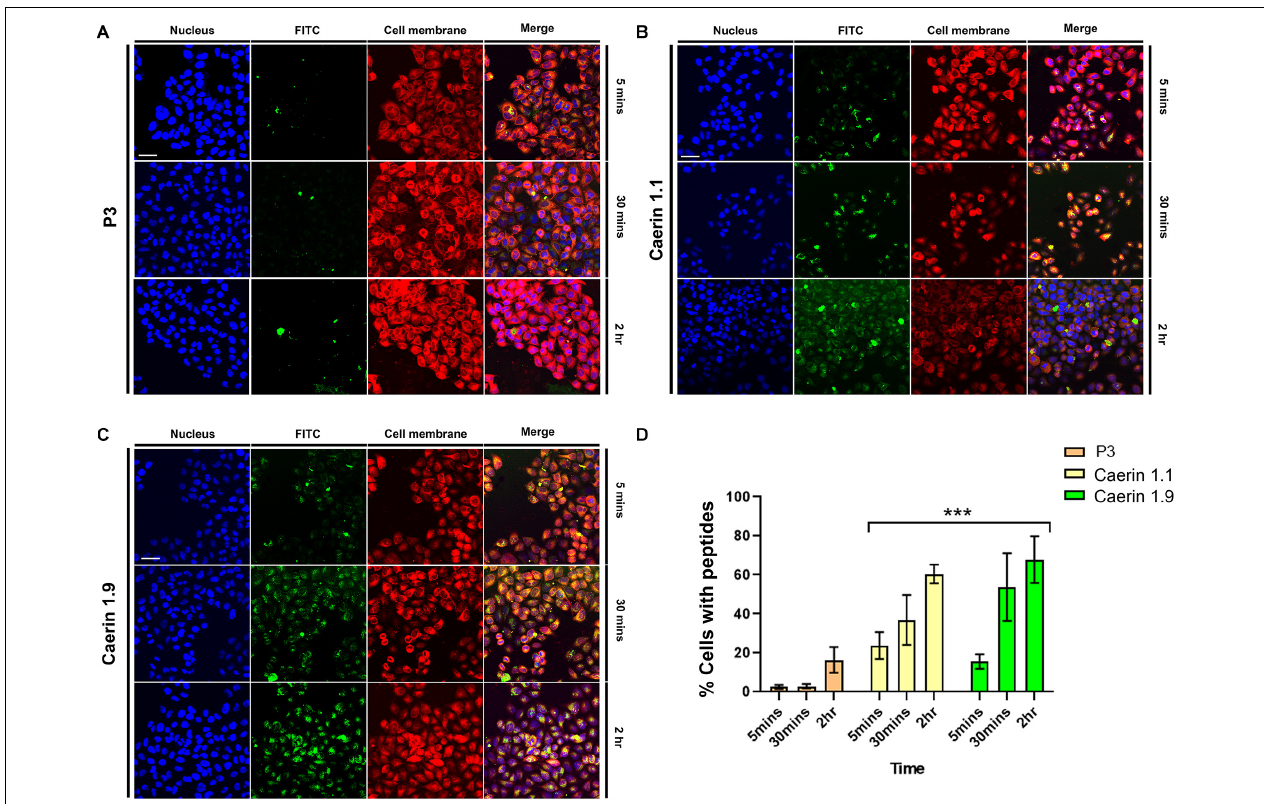
FIGURE 2 | The co-localization of caerin 1.1, 1.9 and P3 in HeLa cells. HeLa cells were treated with FITC conjugated P3 (2.6 nM), caerin 1.1 and 1.9 (1.9 nM) for 5 min, 30 min, and 2 h. Then, cells were fixed by 4% paraformaldehyde and stained with Hoechst (Nucleus Marker, Blue) and CellMask (Cell membrane marker, Red). HeLa cells were treated with (A) P3, (B) caerin 1.1 and (C) caerin 1.9 for 5 min, 30 min, and 2 h. (D) The histogram shows the percentage of col-localization of P3, caerin 1.1, and 1.9 with HeLa cells. Data are shown as mean ± SEM. *** P < 0.001, two-way ANOVA, Tukey’s multiple comparisons test. Scale bar, 25 µ m. The CellProfiler software was used to detect the co-localization of P3, caerin 1.1 and 1.9 with HeLa cells.